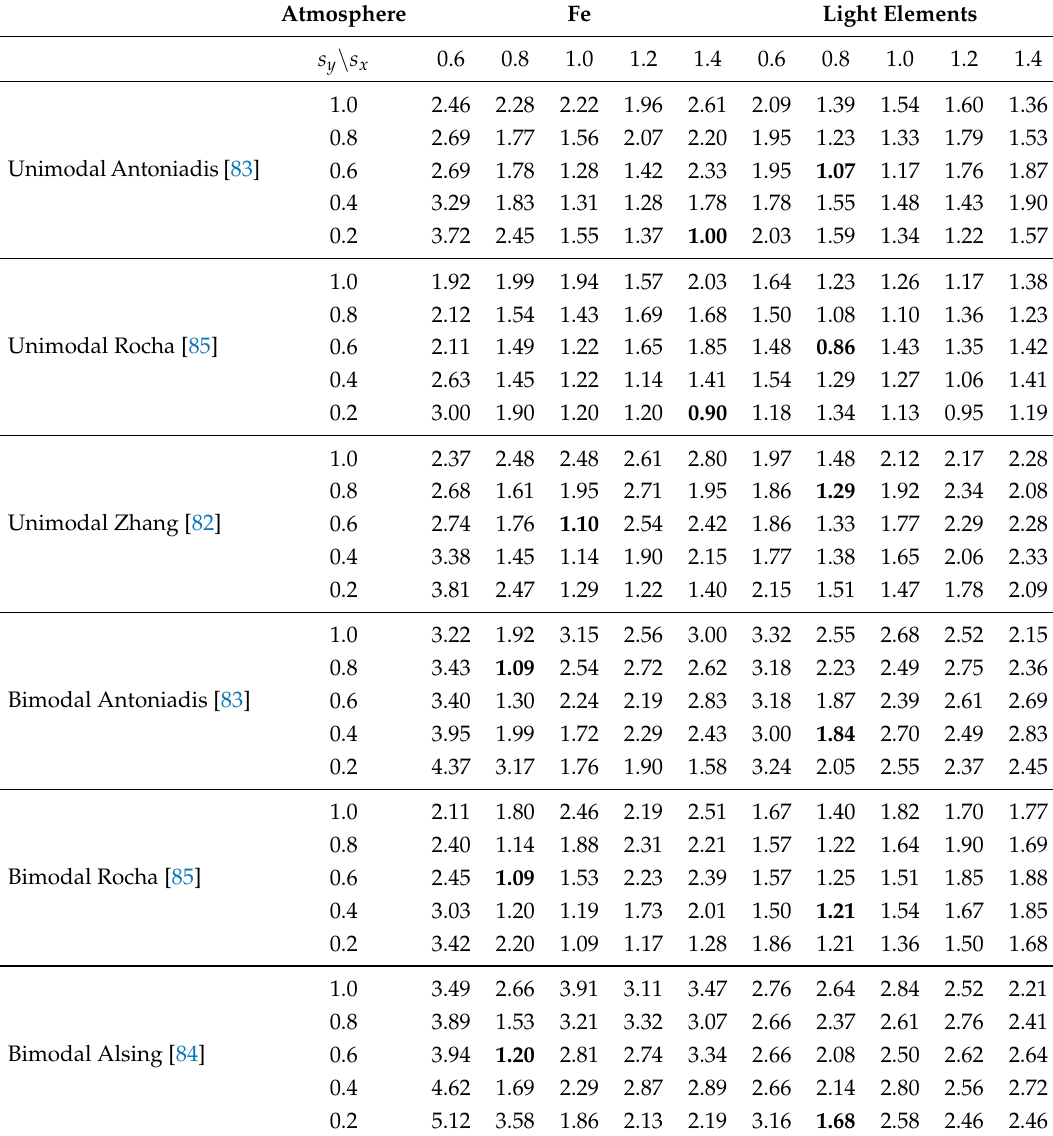
Table 2. Root-mean-square variances between deduced NS mass distributions with different p1S0 gap scale factors s x , s y for Fe or light-elements atmospheres, shown in Figure 5, and different theoretical models [82–85], shown in Figure 6. Preferred values are indicated in